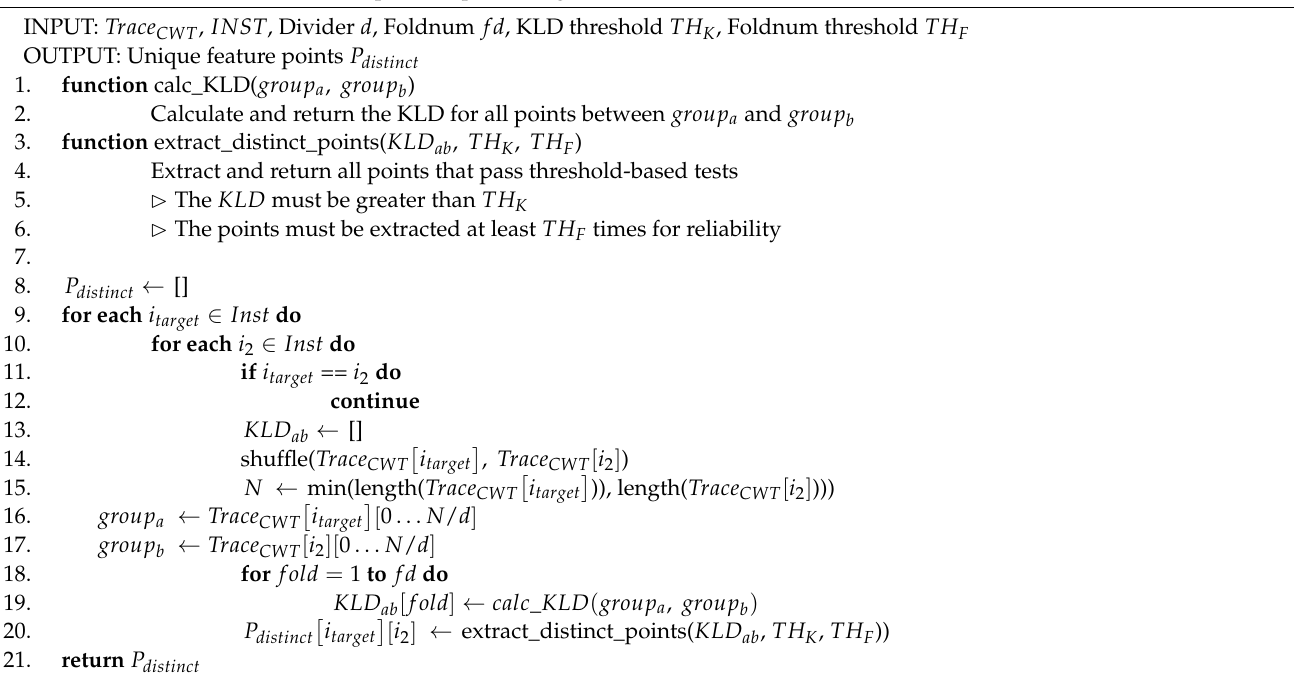
Algorithm 2 Extraction of the feature points representing the distinct characteristics of each